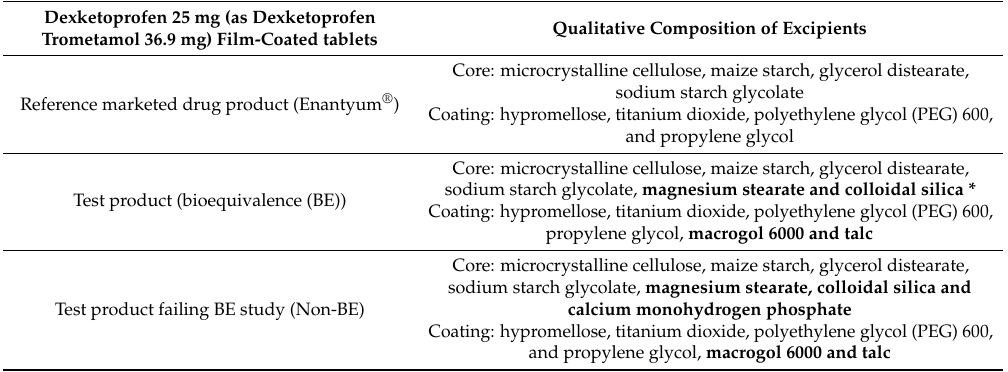
Table 1. Qualitative differential composition of the reference marketed drug product and the test products. The ingredients in bold are the added excipients to the core or the coating of the tablet for both test products, which was not presented in the reference marketed drug product.